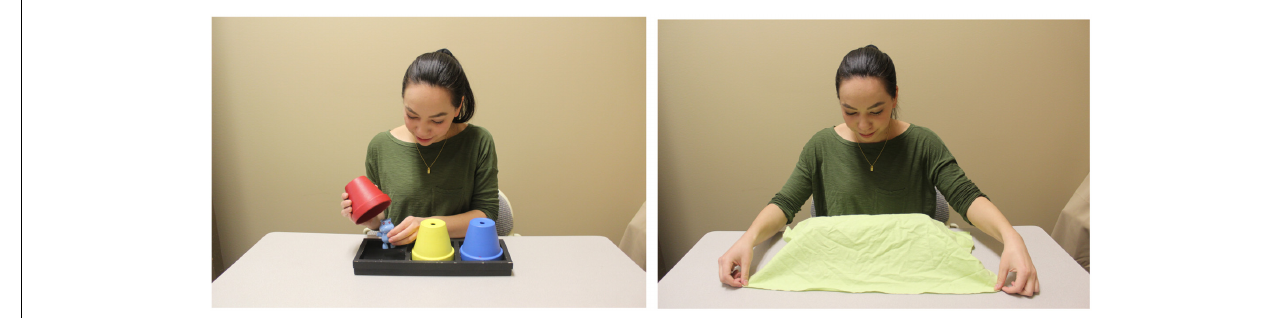
FIGURE 5 | Hide the Pots task: experimenter hiding the toy under one of the opaque pots and covering display with the blanket.